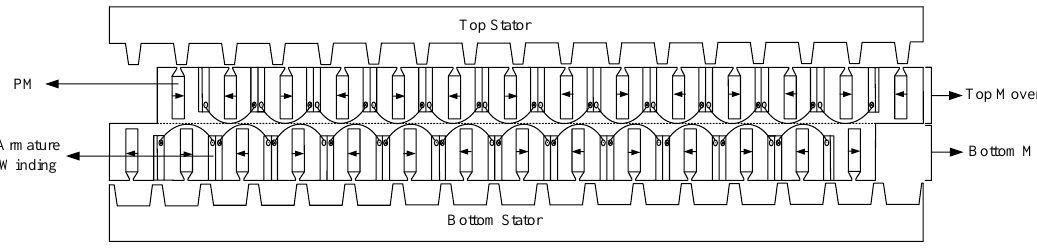
Figure 20. 2D cross-sectional view of DSLFSPMM-MO7.